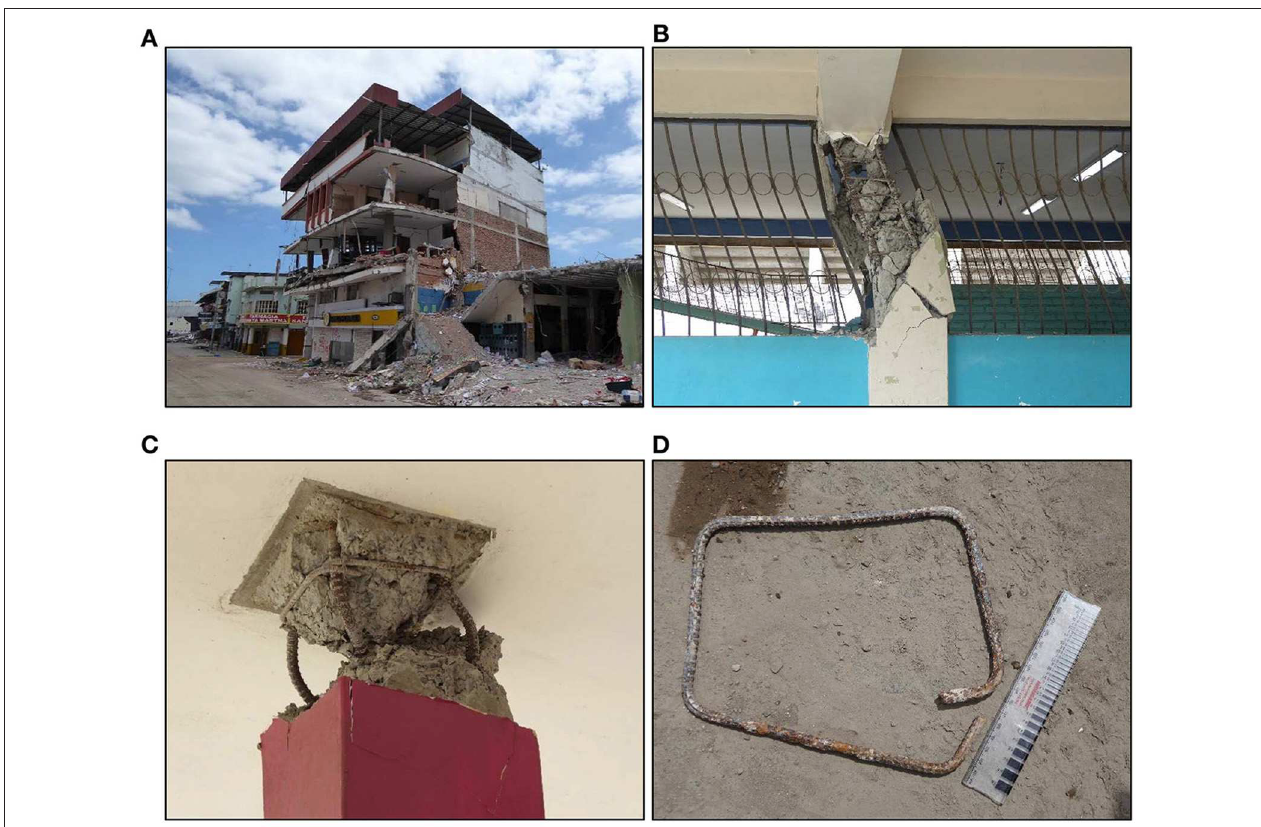
FIGURE 7 | Failures caused by inadequate design of infills and reinforcement detailing following the Muisne earthquake. (A) inadequate design/detailing of RC frame and infills at Portoviejo. (B) School building with short column failure at Pedernales. (C) Column head failure showing insufficient shear design at Portoviejo. (D) insufficient lapping of column link with no 135 ◦ -bend at